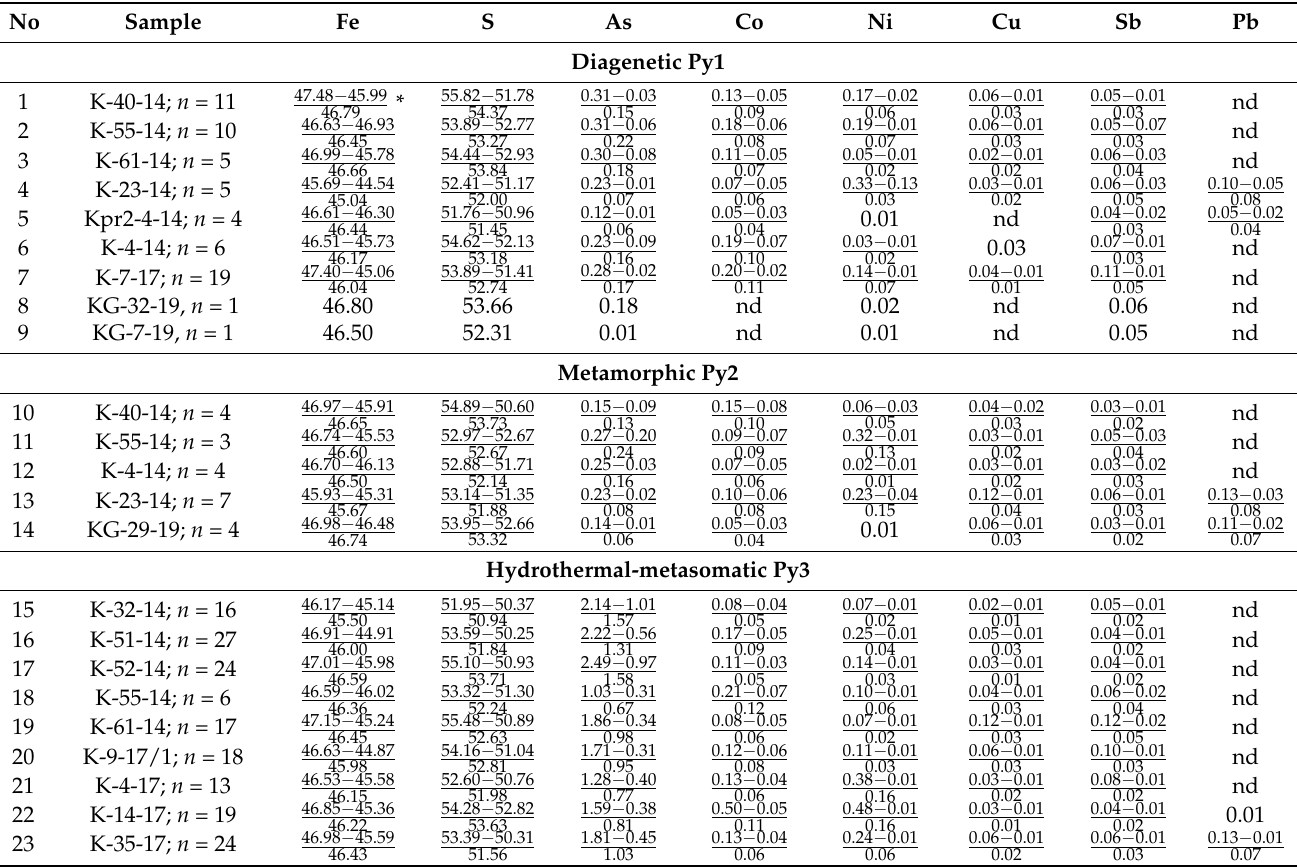
Table 1. Chemical composition of pyrites and arsenopyrites determined by EPMA (all values in wt.%.; nd, not detected).